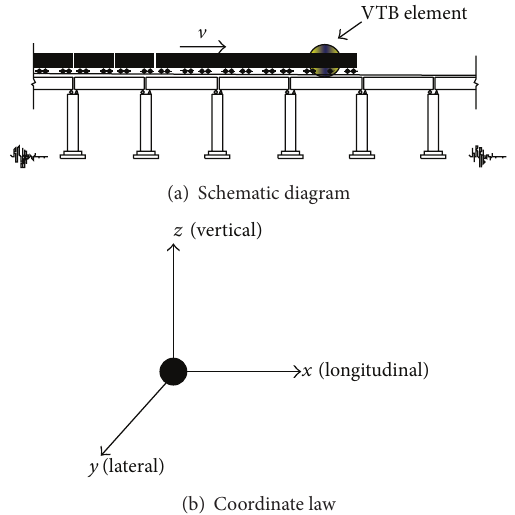
Figure 4: Global model of vehicle-bridge